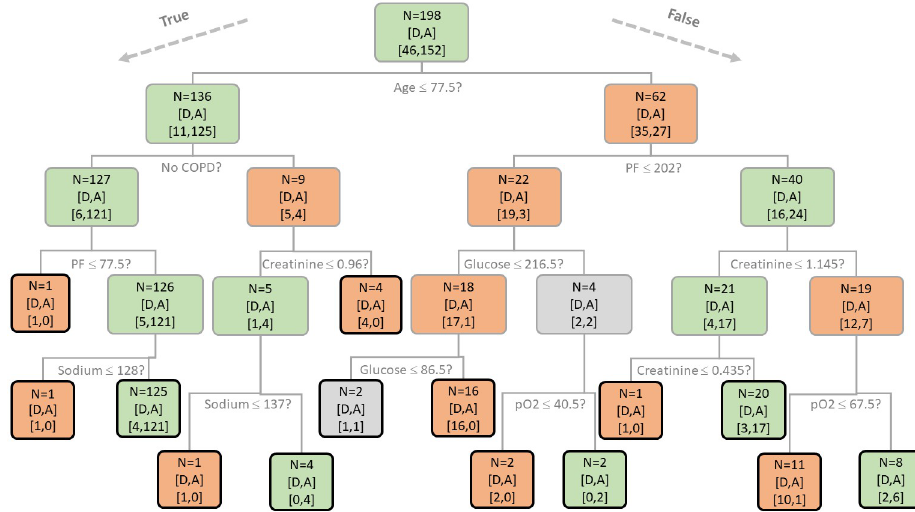
Fig 4. BDT obtained with a train-all setting. BDT trained with the features included in the graph analysis reported in Fig 3. The color of the squares represents the class prevalence: red for deaths, green for recoveries and grey in case of parity. The number of subjects is indicated in the first line of each square, while the last line reports deaths/recoveries. Black edges denote leaves.